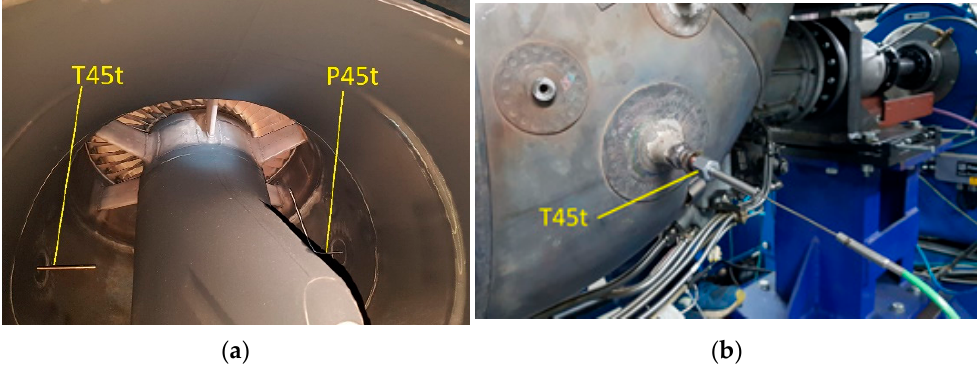
Figure 10. Free turbine total outlet pressure and temperature probe ( a ); free turbine total outlet temperature probe location ( b ).